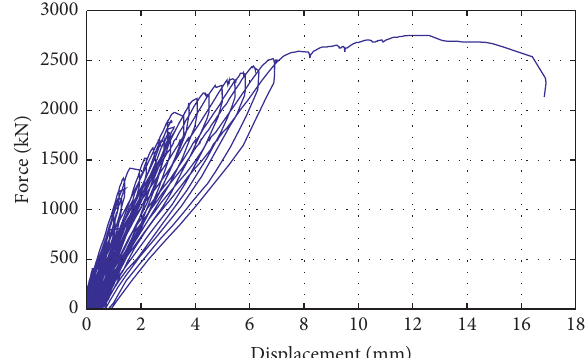
Figure 13: Load-displacement diagram.